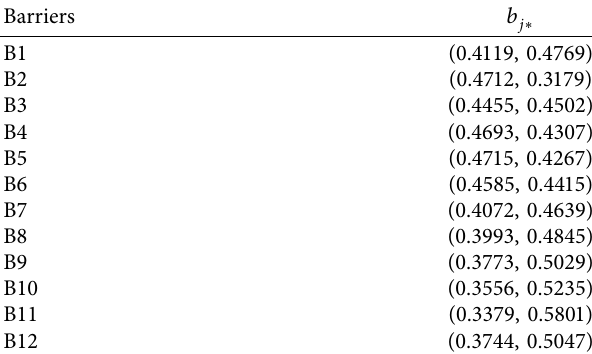
Table 10: The negative ideal solution. Barriers